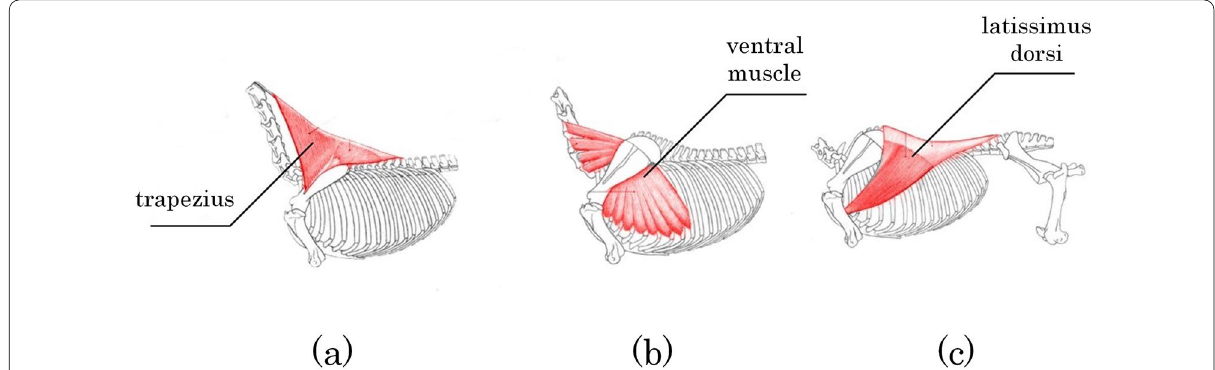
Figure 2 Major muscles of the ruminant dorsal muscle groups: a trapezius, b ventral muscle, c latissimus